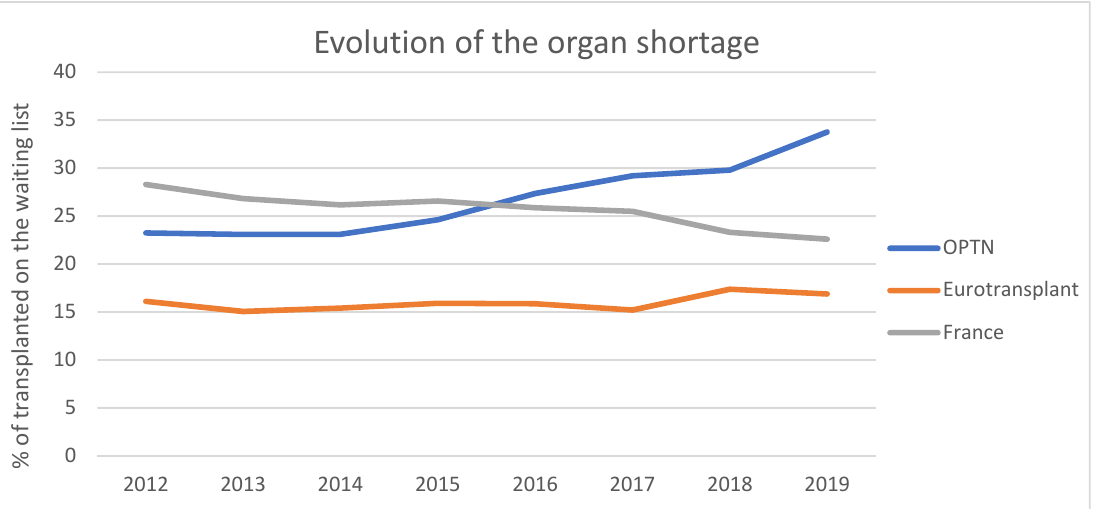
Figure 1. Evolution of the number of organ transplants performed as a percentage of the waiting list in several transplantation areas: France, Eurotransplant and Organ Procurement and Transplantation Network (OPTN).